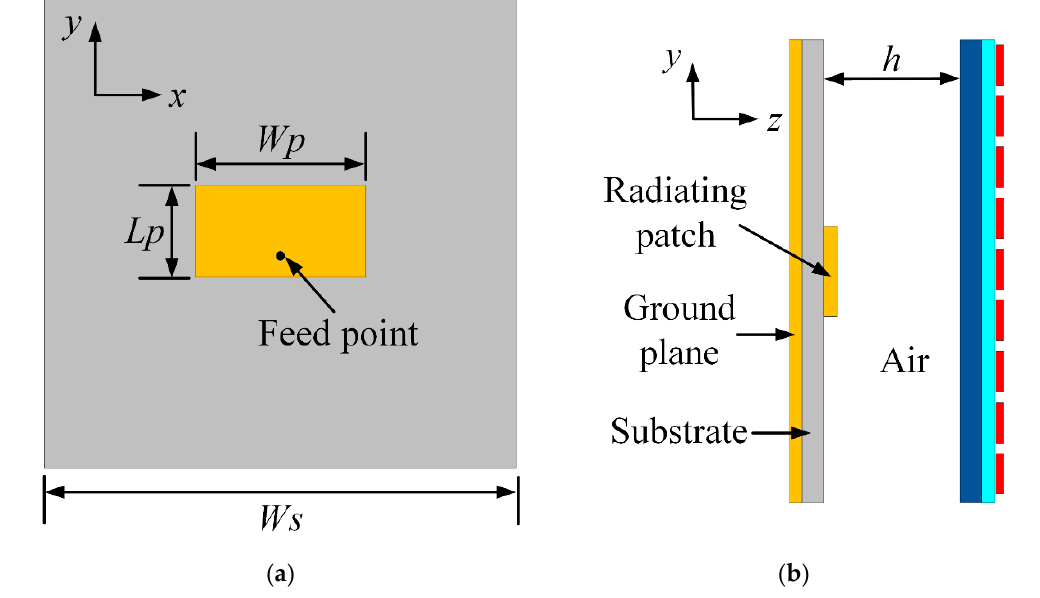
Figure 3. ( a ) The geometry of patch antenna ( b ) MS antenna.